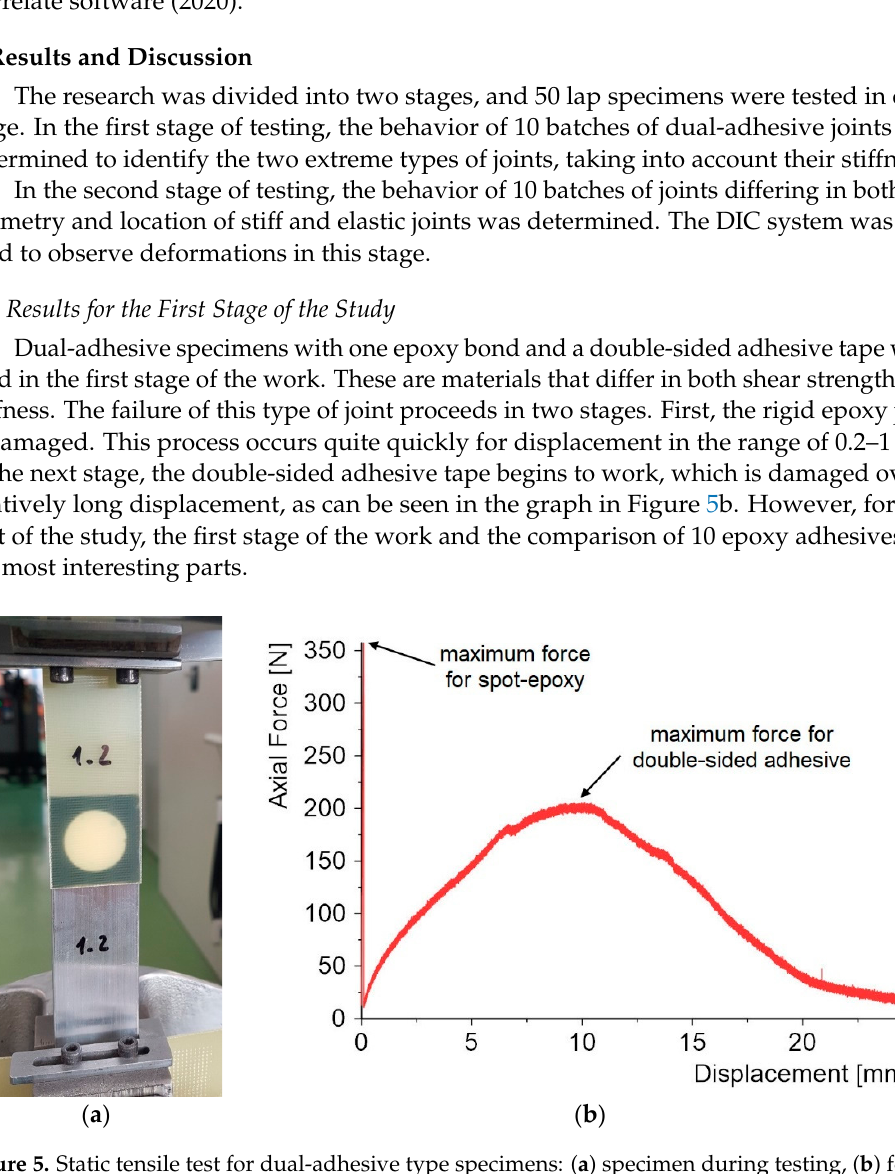
Figure 6. Summary of results of the first stage of joint operation: ( a ) summary of maximum forces, ( b ) comparison of stiffness for epoxy joints. Figure 6a shows the maximum force values for 10 batches of dual-adhesive speci- mens. The maximum force value in each case was obtained for the epoxy joint. The highest maximum force (2172 N) was achieved for joints using Scotch-Weld 2216 adhe- sive (batch 2). The lowest value (588 N) was achieved by joints using Distal Classic ad- hesive (batch 1) and Epidian 5 (100 g) + “Z1” hardener (10 g) (batch 3). Figure 6b was created by connecting point (0, 0) with the points corresponding to the maximum force and displacement, i.e., the failure of the epoxy joint, whose characteris- tics are linear. The type of resin or adhesive used, as well as the proportion of hardener